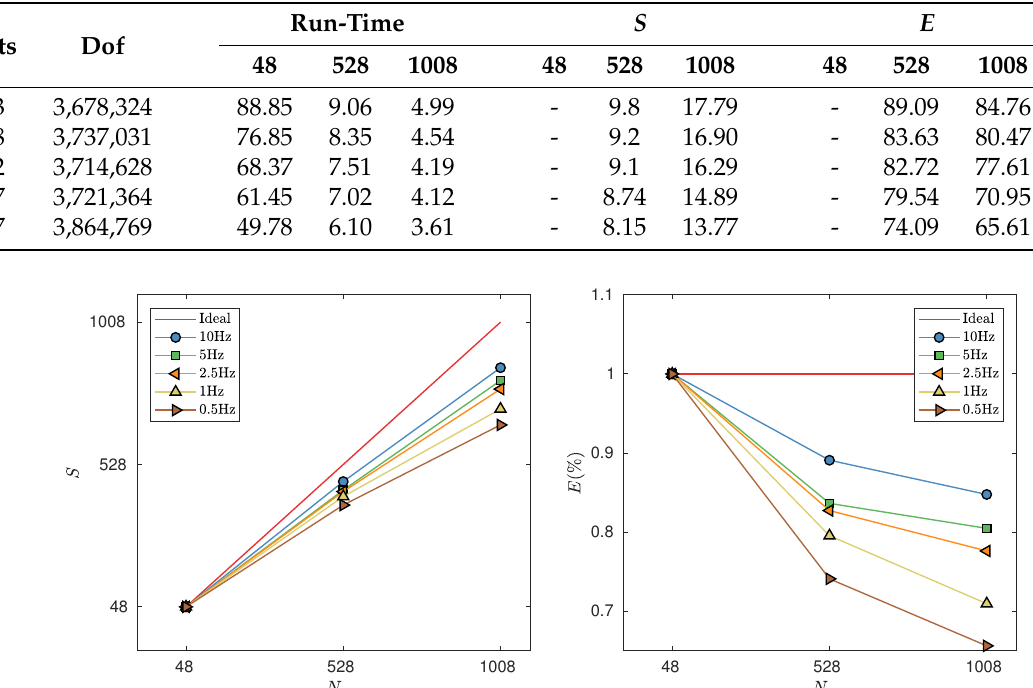
Table 1. Statistics of adapted meshes and performance results for 3D-VTI-B model. The frequency (Hz), number of elements, number of dof, run-time (minutes), speed-up S , and parallel efficiency E (%) for five relevant simulations are given.